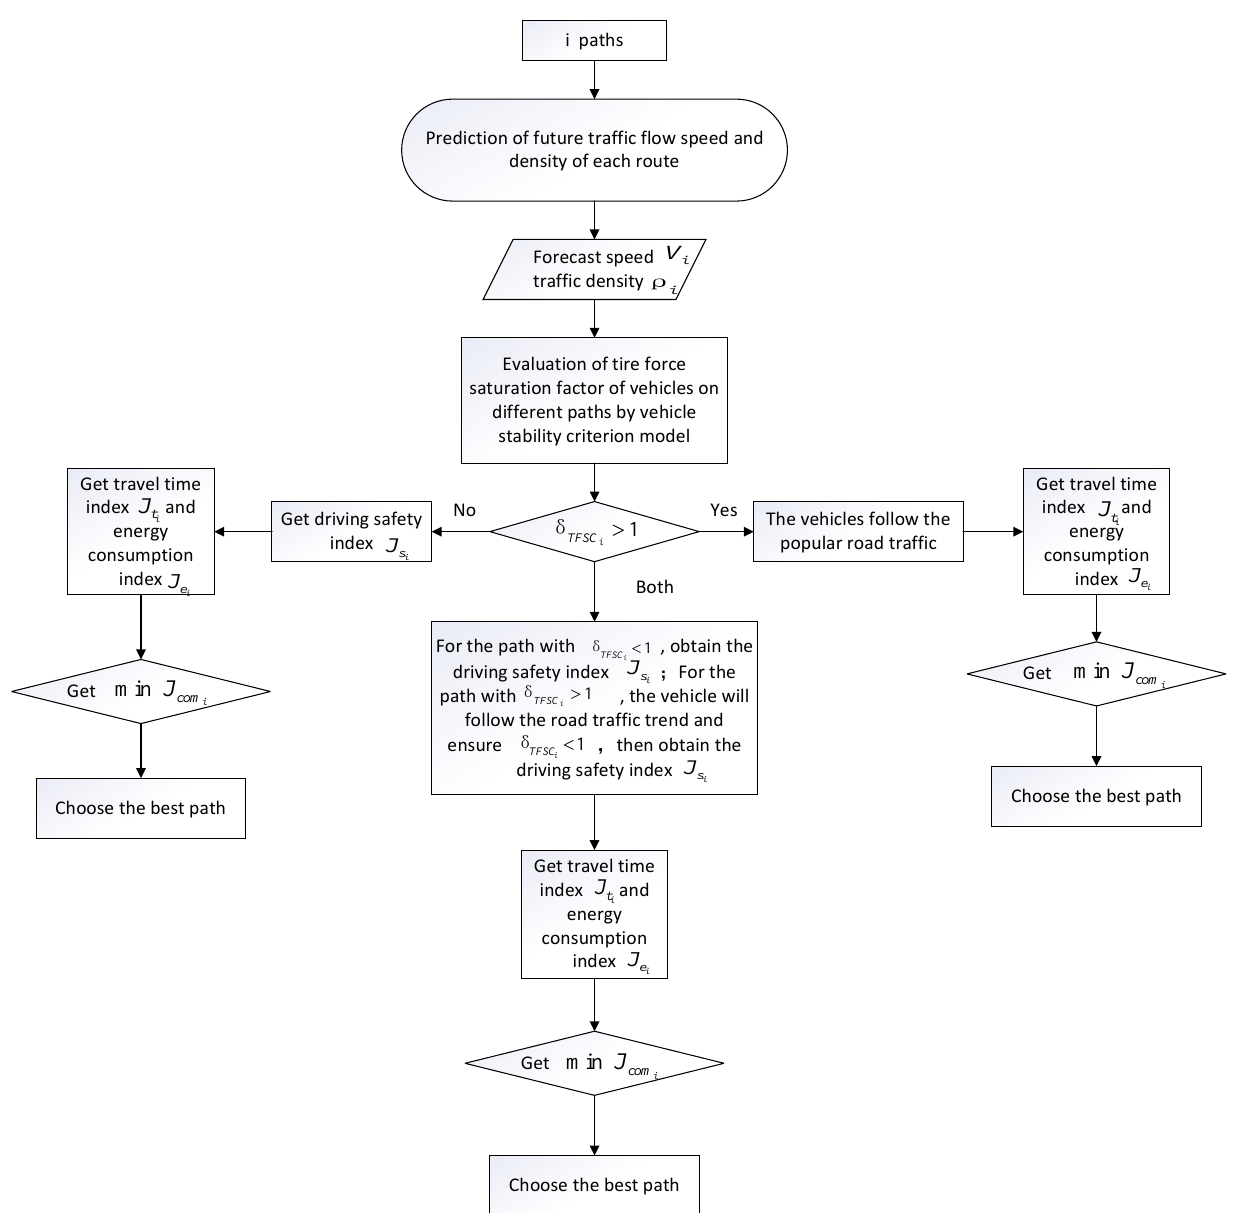
Figure 14. Path planning/selection logic diagram based on multi-objective optimization.